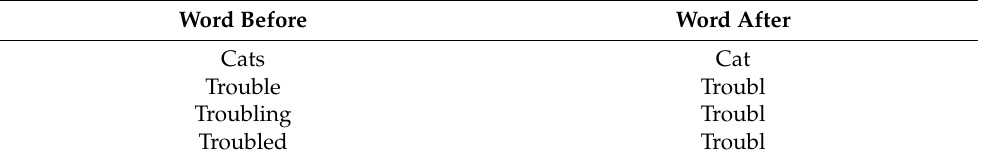
Table 1. Examples of stemming with PS.